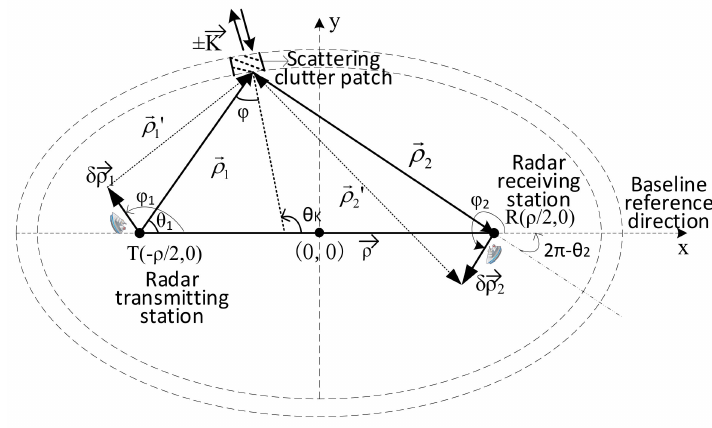
Figure 1. First-order bistatic shipborne HFSWR scatter geometry.